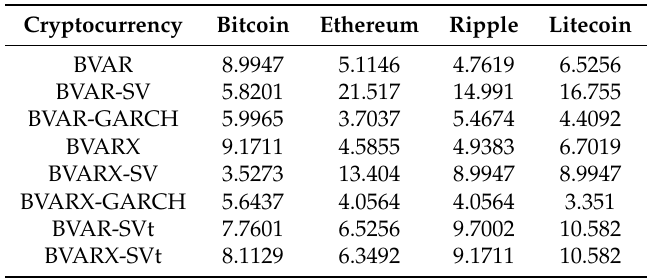
Table 2. Percentage of actual observations outside of the 95% credible interval retrieved by